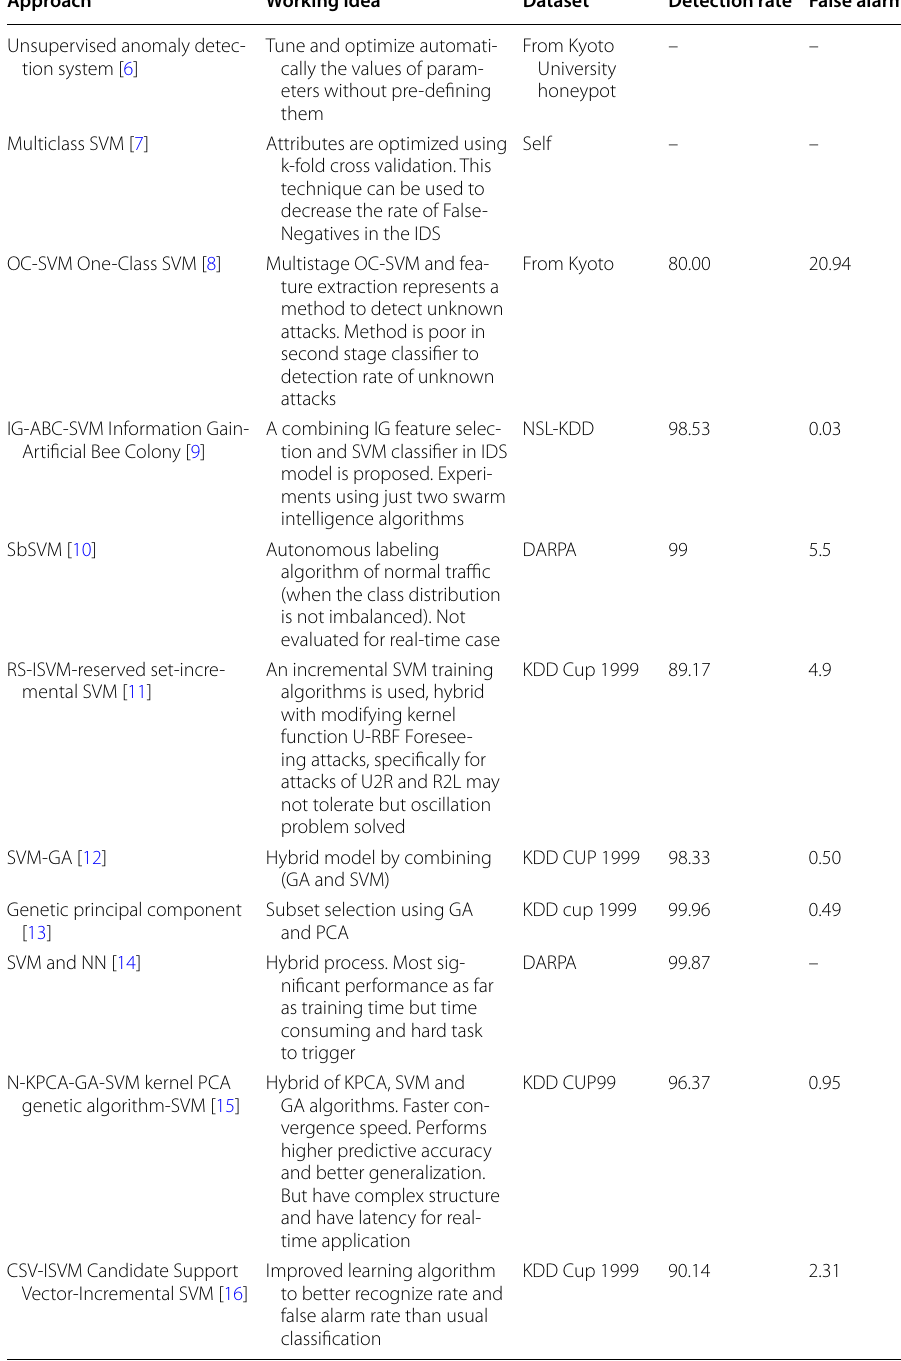
Table 2 Comparisons between researches that used SVM as basic classifier Approach Working idea Dataset Detection rate False alarm Unsupervised anomaly detec- Tune and optimize automati- From Kyoto tion system [6] cally the values of param- University eters without pre-defining them